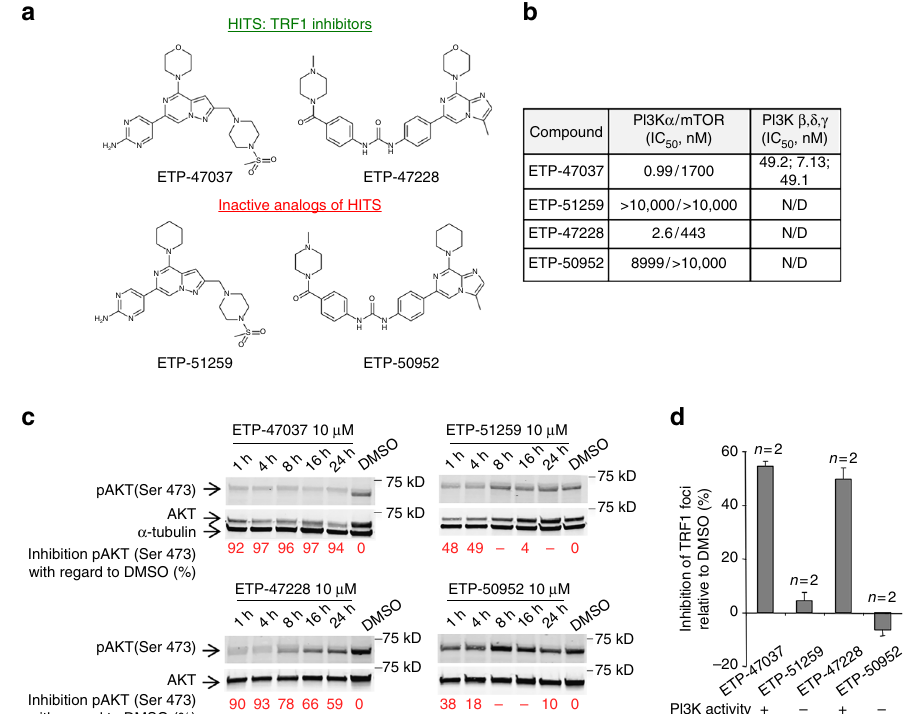
Fig. 1 Chemical inhibition of TRF1 binding to telomere by PI3K inhibitors. a Structures of ETP-47037, ETP-47228, and their corresponding “ inactive analogs ” ETP-51259 and ETP-50952. b PI3K/mTOR IC 50 data generated internally and reported for the inhibitors used in the study. c Time course Inhibition of AKT phosphorylation at Ser473 by ETP-47037, ETP-51259, ETP-47228, and ETP-50952 at 10 μ M in CHA-9.3 cell line. d Percent inhibition of TRF1 foci by immuno fl uorescence in CHA-9.3 mouse lung tumor cell line treated with 10 μ M of either ETP-47037, ETP-47228, or their corresponding inactive analogs (ETP-51259 and ETP-50952, respectively) relative to TRF1 levels with DMSO treatment. The ETP compound inhibitory activity on PI3K pathway is stated at the bottom of the graph. Error bars represent standard deviation. N/D not determined, n number of independent